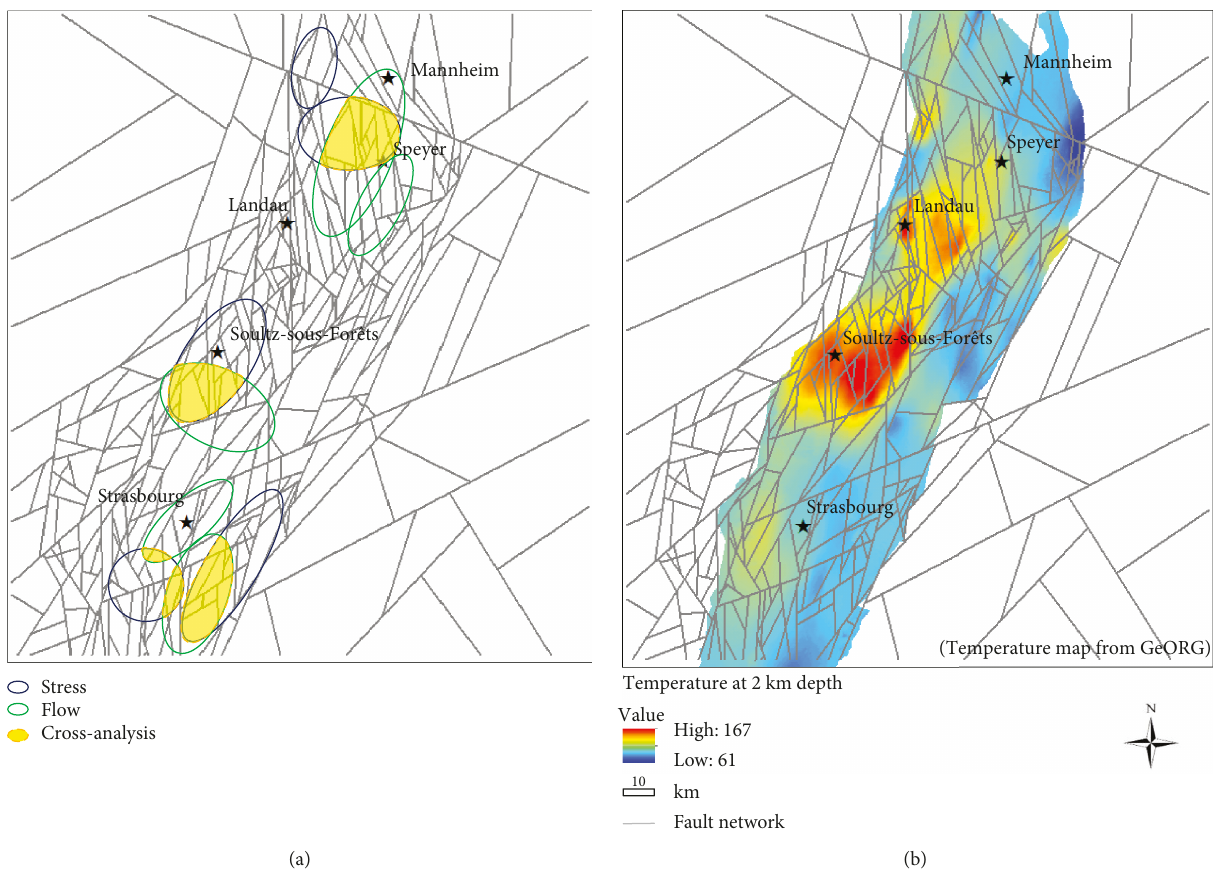
Figure 9: (a) The results of the cross-analysis based on the overlapping of the respective favourable areas issued from the stress and fl ow models. (b) Map of temperature at a 2 km depth obtained from the GeORG